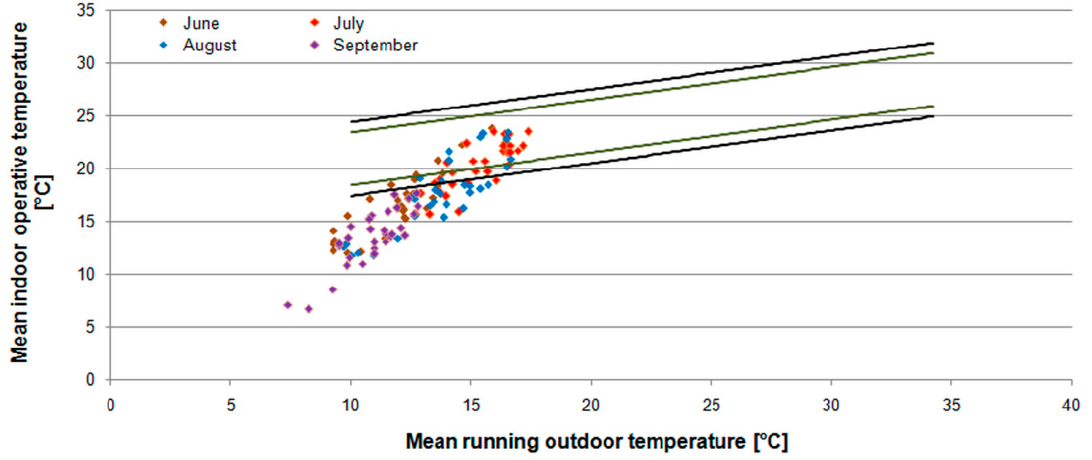
Figure 10. Comfort zone of EN 15251 and daily operative temperature in analyzed months in the case 3 (case 2 + night ventilation). Category I: green lines, Category II: black